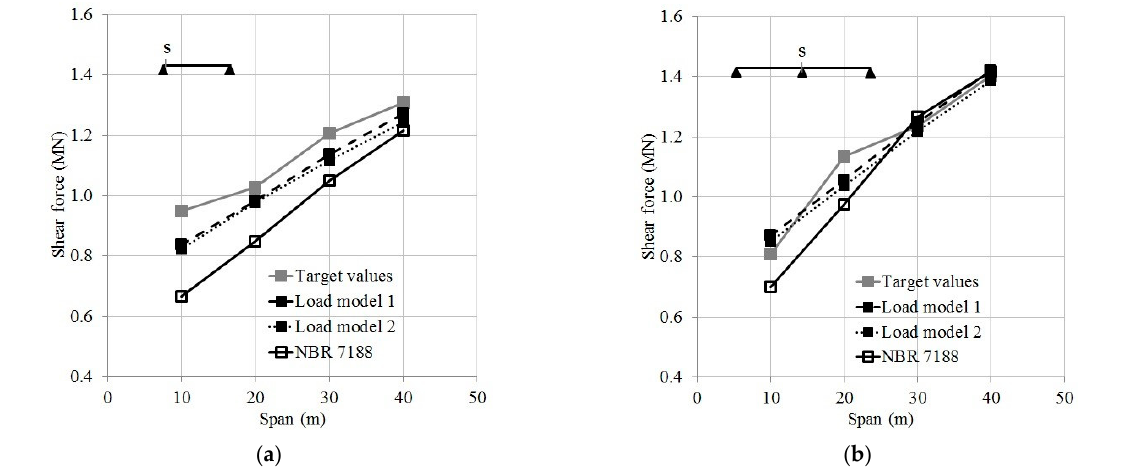
Figure 9. Comparison between the effects generated by the load models and the target values. ( a ) Shear forces on simply supported bridges. ( b ) Shear forces on continuous bridges.